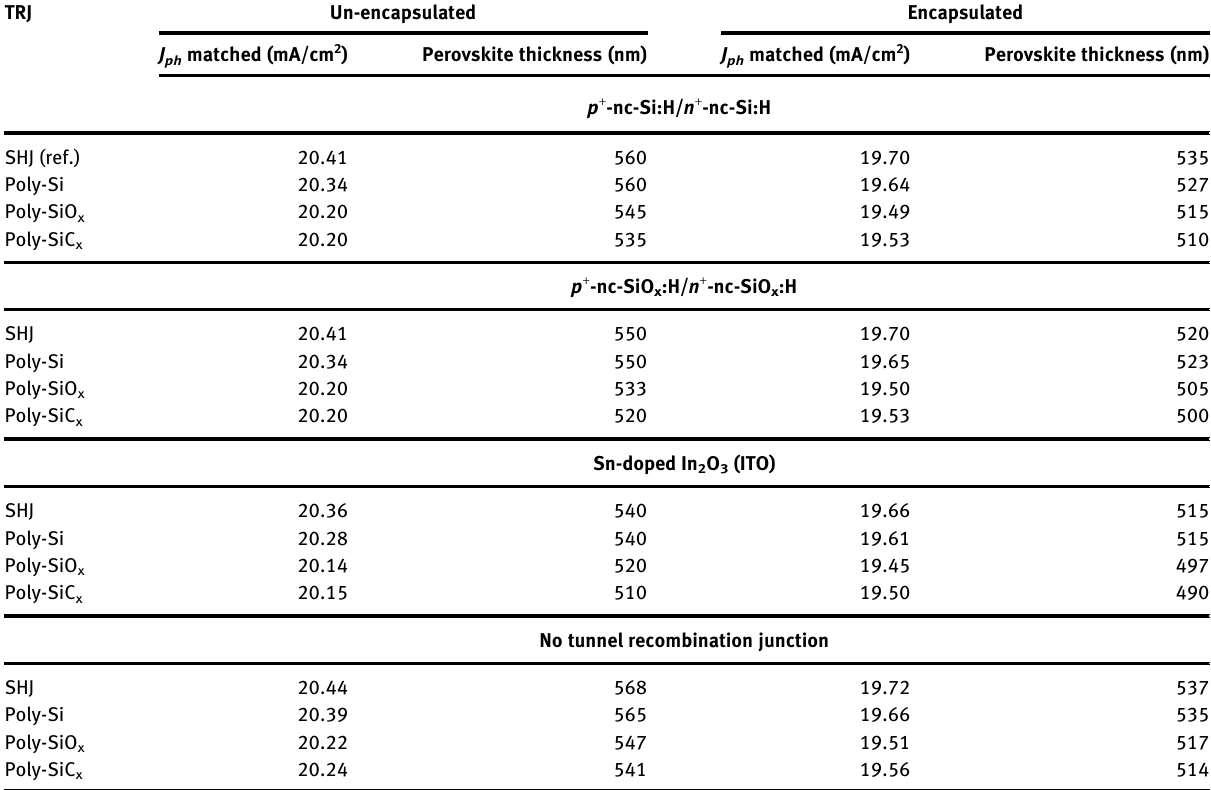
Table  : Implied photocurrent density ( J ph ) of  T tandem with different